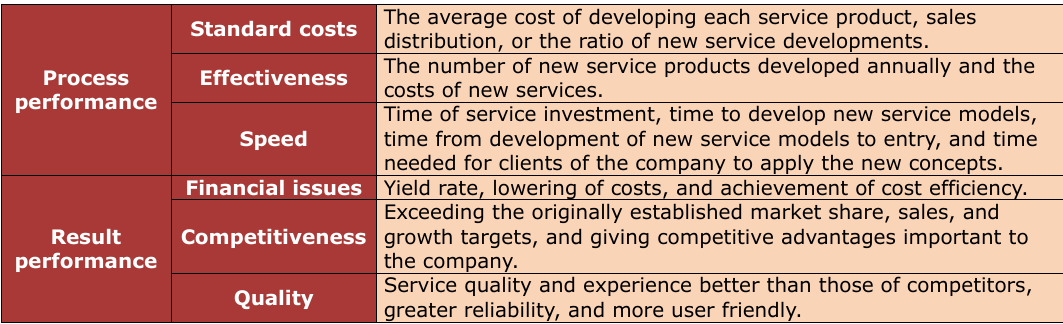
Table 1. The Measurement of Service Innovation